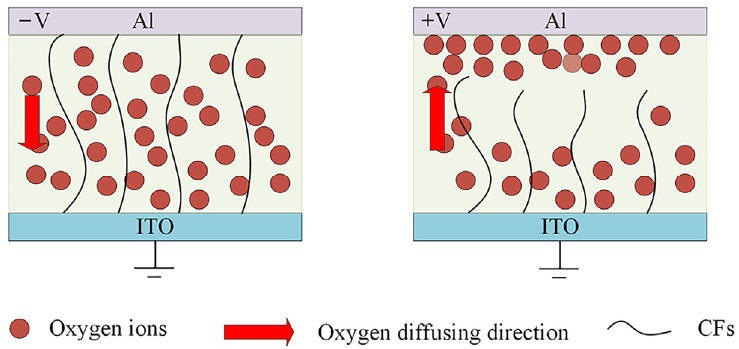
Figure 12. Conductivity diagram of the Al/SH/ITO device.